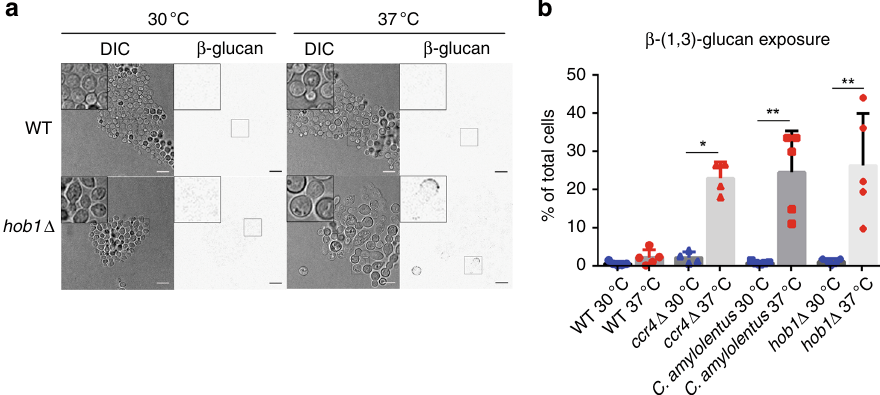
Fig. 7 The transcription factor, Hob1, contributes to cell wall masking at 37 °C. a Wild-type C. neoformans , the ccr4 Δ mutant, the wild-type C. amylolentus, and the C. neoformans hob1 Δ mutant strains were grown at 30 °C or 37 °C and stained with β -(1,3)-glucan antibody for fl uorescence microscopy. Scale bar = 10 µ m. Insets show magni fi ed views cells outlined in boxes. Glucan exposure was measured by fl ow cytometry ( b ). Graphs are representative of the mean percentage of cells ± s.e.m. ( n = 5) exposing β -(1,3)-glucan, and signi fi cance was determined by Kruskal – Wallis and Dunn ’ s test post hoc. Source data are provided as a Source Data fi